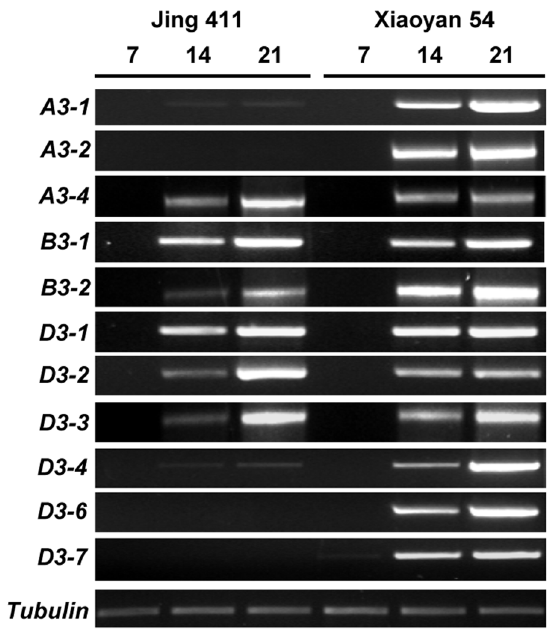
Figure 3. Transcriptional profiles of LMW-GS genes in devel- oping grains of Jing 411 and Xiaoyan 54. Total RNA samples, extracted from developing grains at 7, 14 and 21 days post anthesis (DPA), were used for evaluating transcript levels of the LMW-GS gene members. The 11 LMW-GS genes were all highly transcribed in the developing grains of Xiaoyan 54 at 14 and 21 DPA. By contrast, in the developing grains of Jing 411, only 6 members ( A3-4 , B3-1 , B3-2 , D3-1 , D3-2 , D3-3 ) were highly transcribed at 14 and 21 DPA; two members ( A3-1 , D3-4 ) were weakly transcribed, and the transcripts of 3 members ( A3-2 , D3-6 , D3-7 ) were undetectable by RT-PCR at the same time points. The amplification of wheat tubulin gene transcripts served as an internal control for normalizing the cDNA contents before PCR and checking the kinetics of thermamplification during PCR. 99.71% for D3-1 alleles, 100% for D3-2 alleles, and 92.43% for